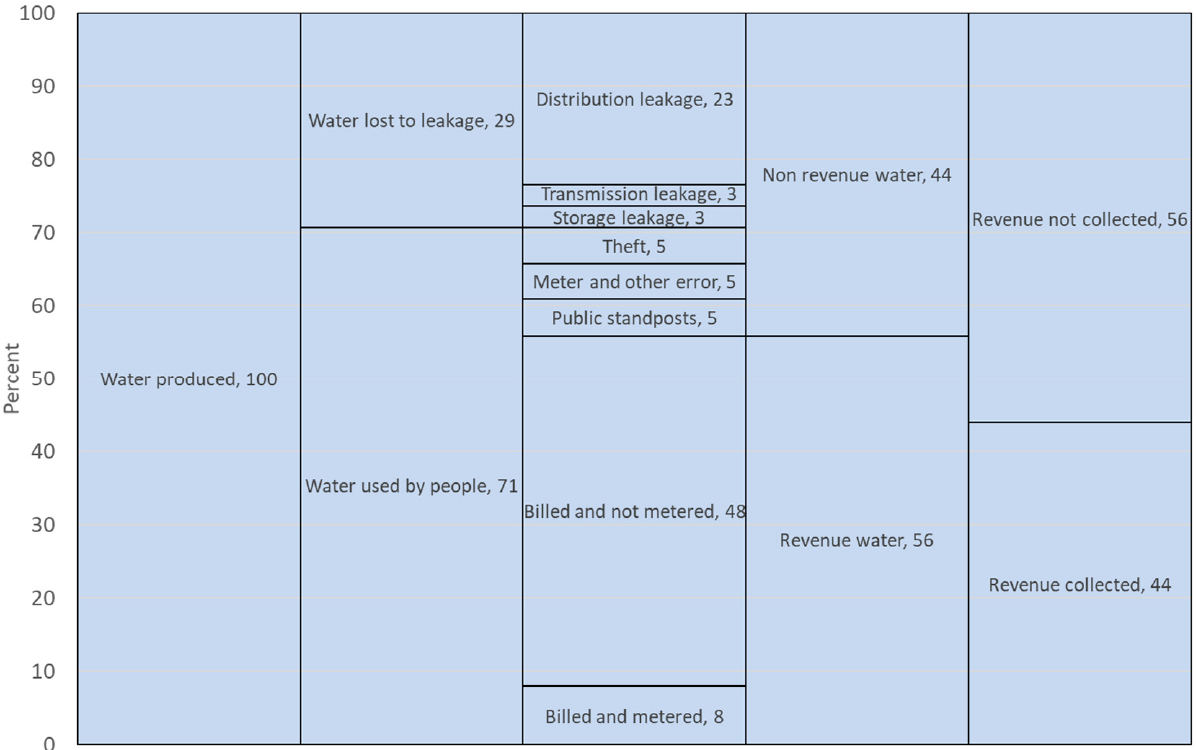
Figure 7. Water balance of a typical South Asian urban water utility, in percent.